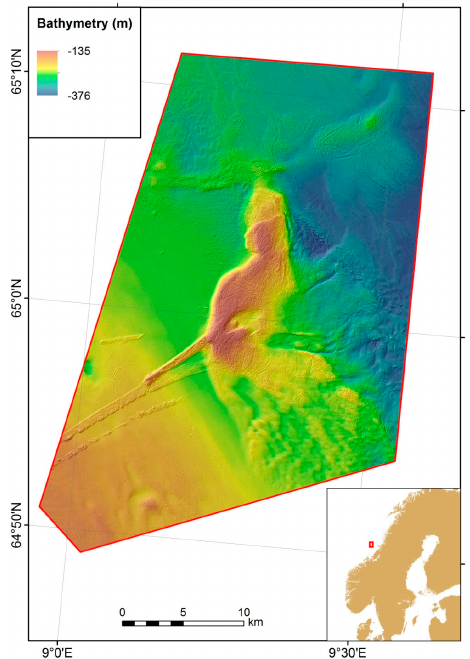
Figure 1. Map showing bathymetry in the study site Iverryggen. Inset map shows the location of the study site off the coast of Norway.